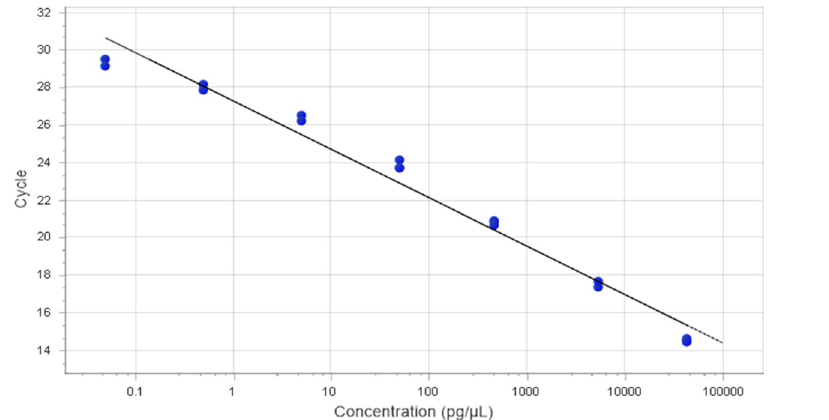
Fig 3. Calibration curve of serial dilutions of A . pleuropneumoniae ATCC DNA.